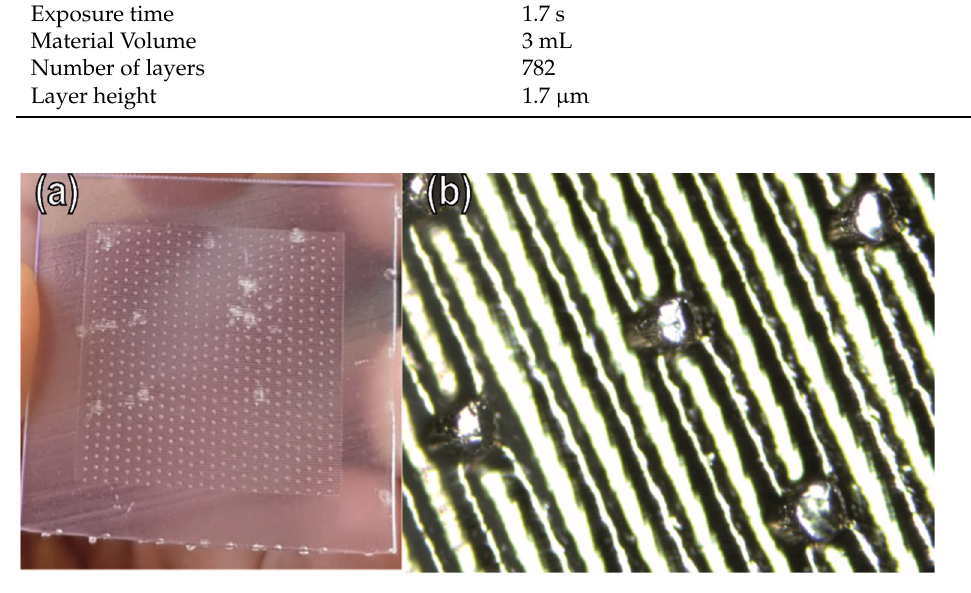
Figure 5. ( a ) Printed mould; ( b ) optical microscope image presenting the details of the printed model.